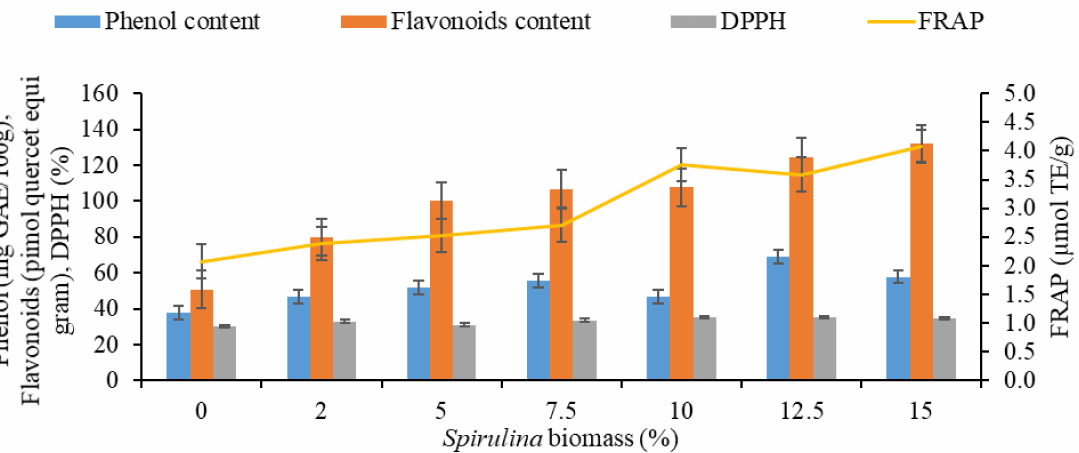
Figure 5. Total phenolic, flavonoid and antioxidant content of cooked pasta enriched with different concentration of Spirulina